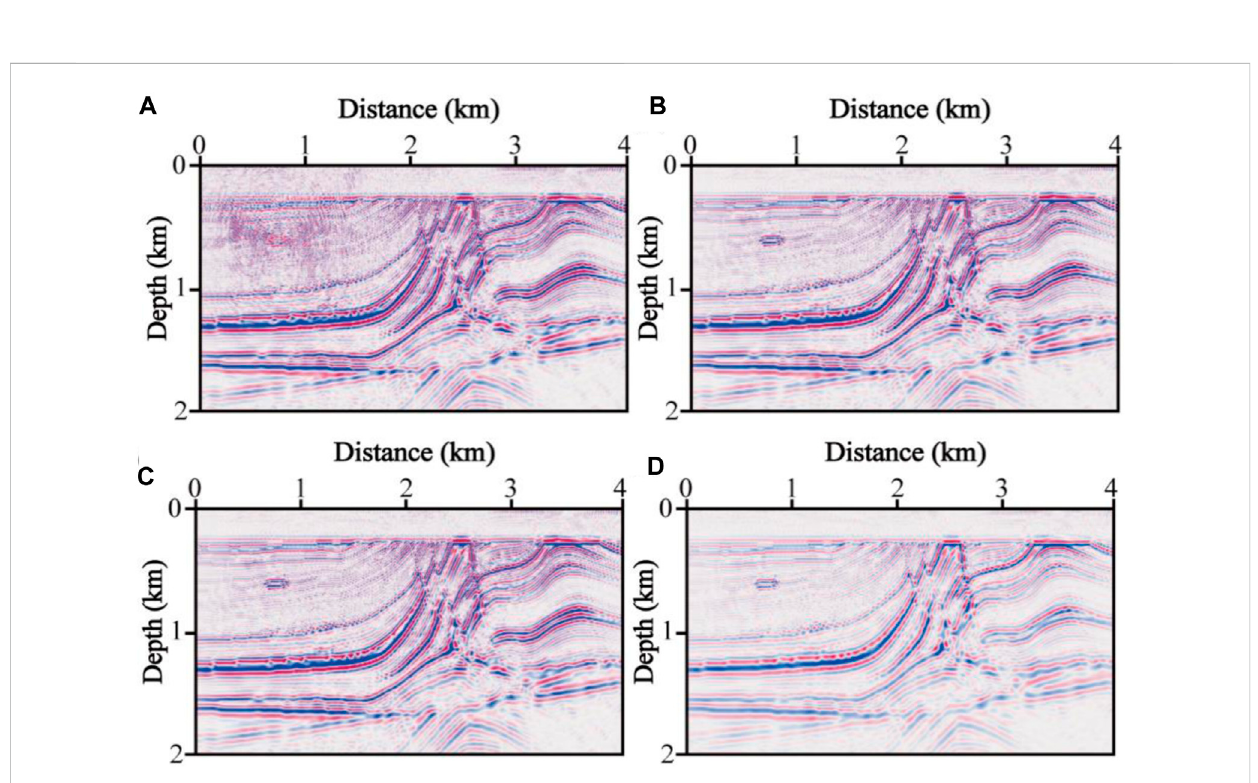
FIGURE 8 Migration results of the Marmousi model with different σ . (A) σ (cid:1) 0 . 1ref; (B) σ (cid:1) 0 . 5ref; (C) σ (cid:1) ref; (D) σ (cid:1) 10ref.